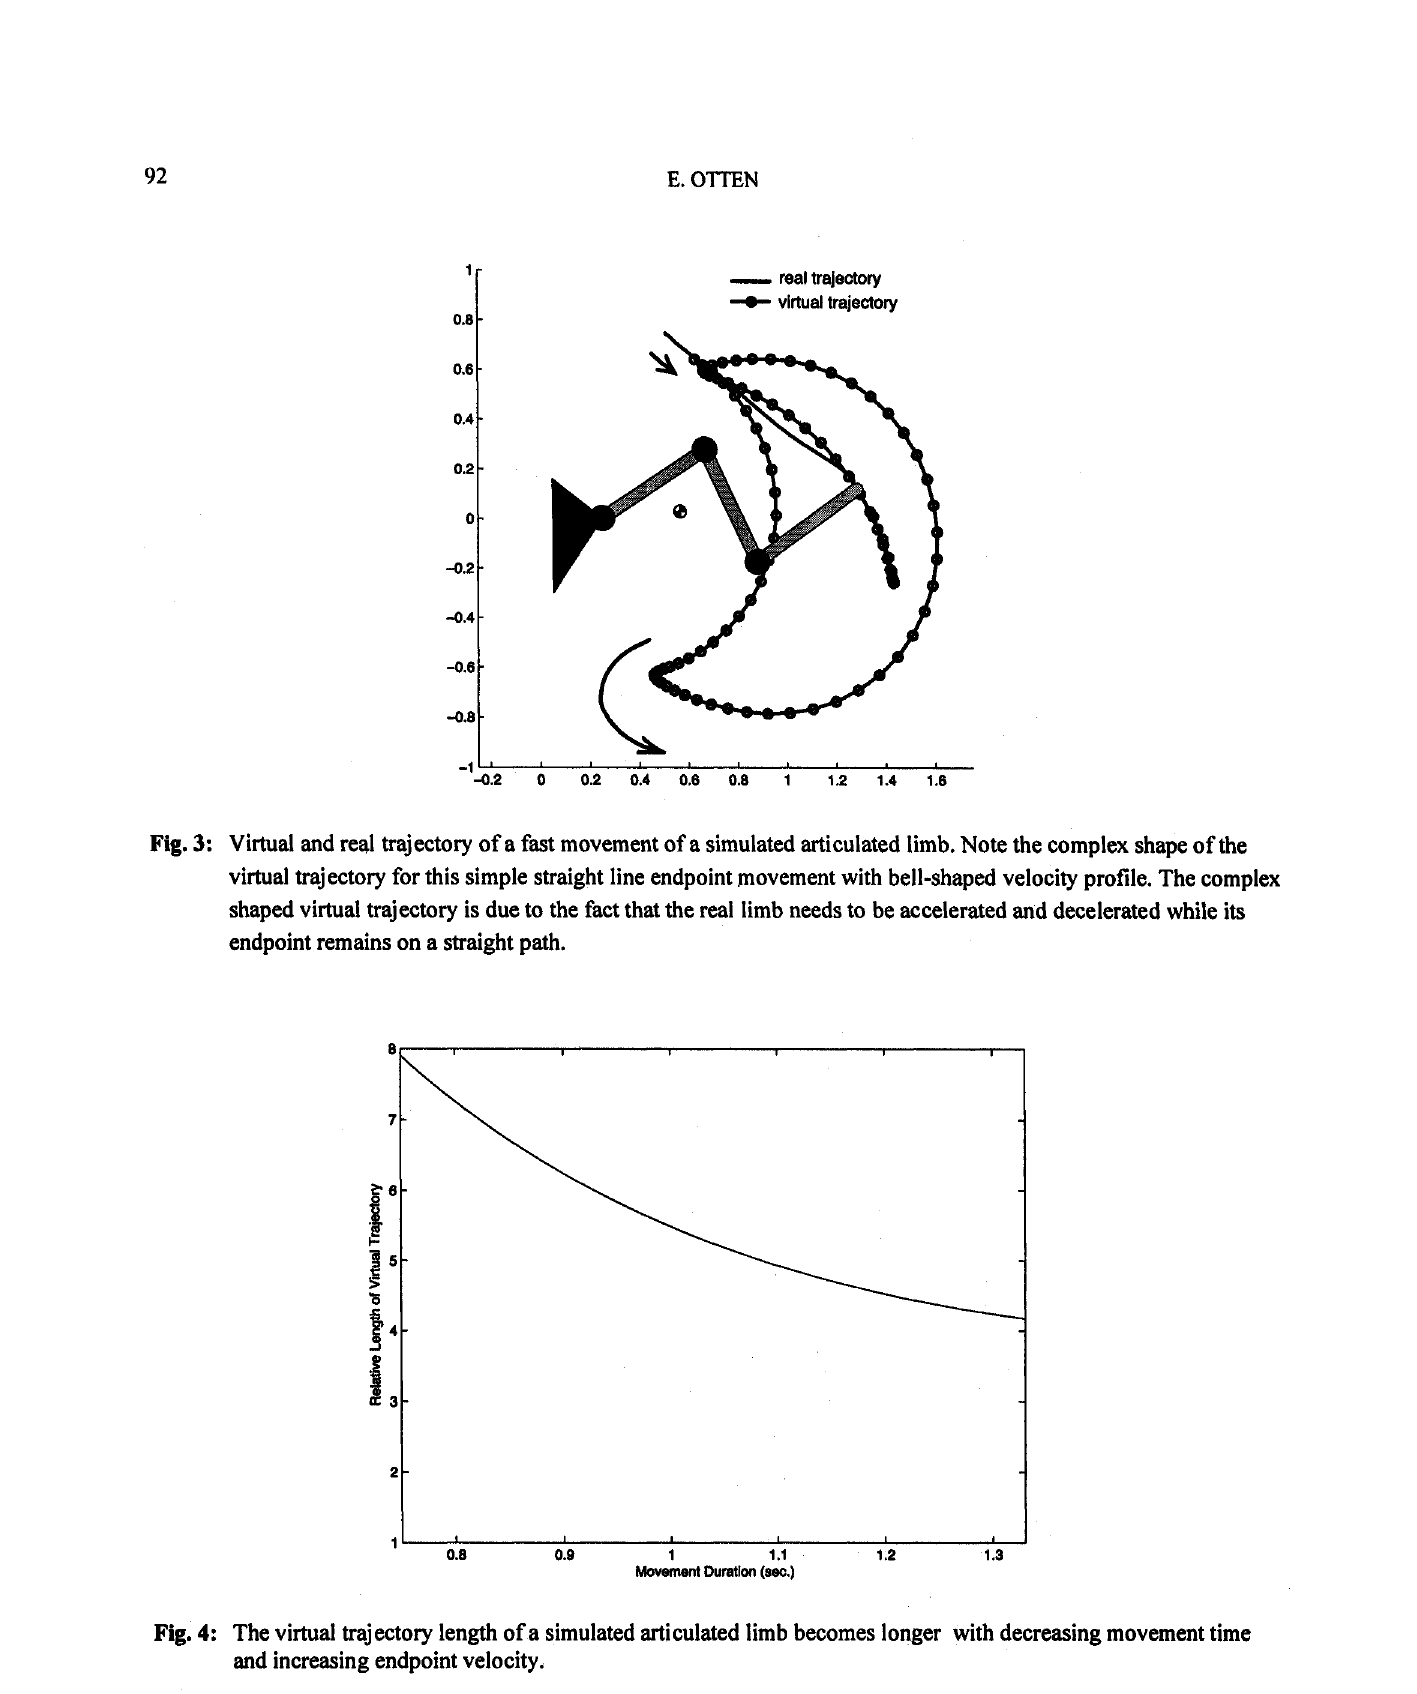
Fig. 4: The virtual trajectory length of a simulated articulated limb becomes longer with decreasing movement time and increasing endpoint